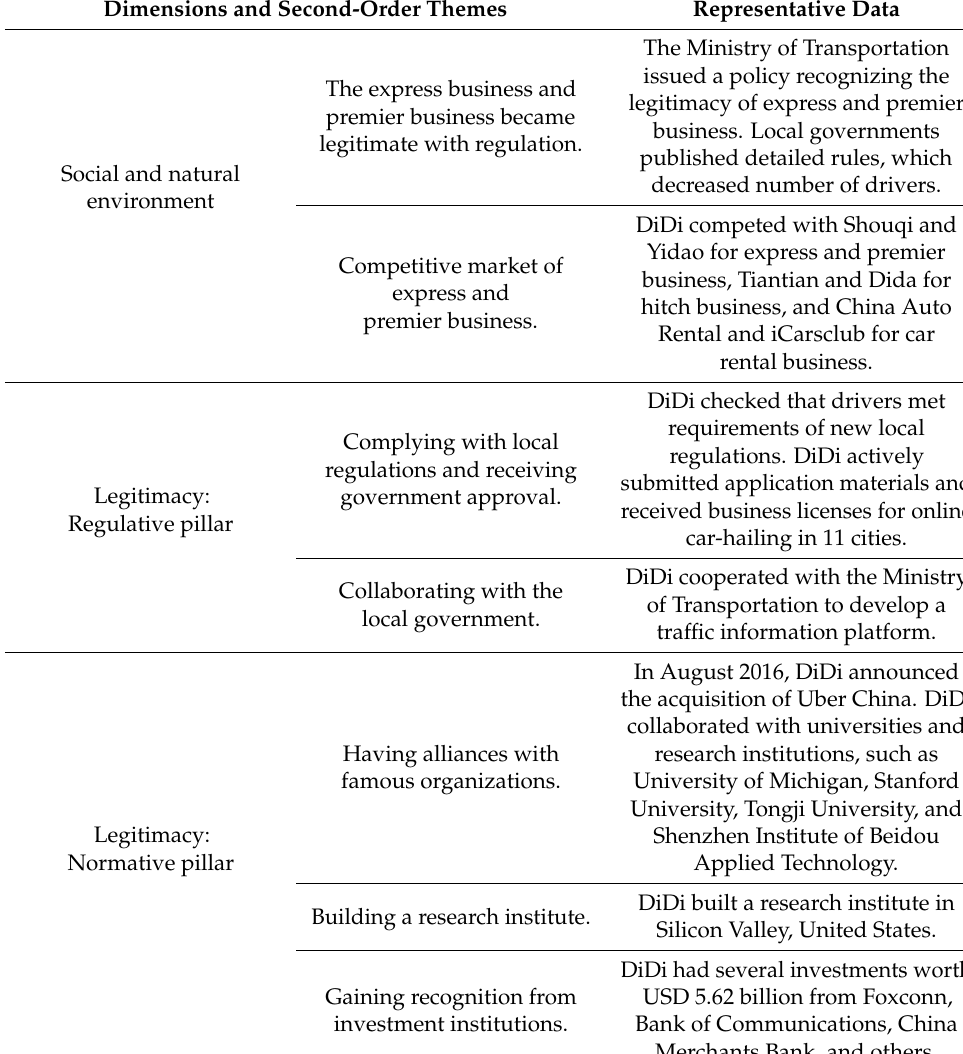
Table 6. Dimensions, themes and data in the phase of strict regulatory requirements for